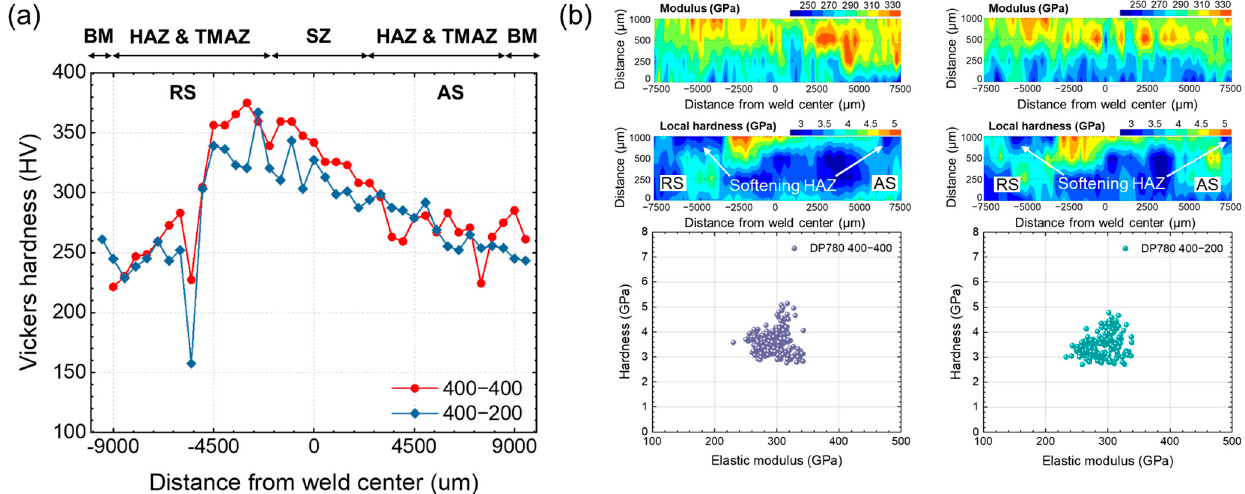
Figure 3. ( a ) The microhardness profile and ( b ) cross-sectional local hardness maps (4 × 60 = 240 indent matrix with a spacing of 250 μ m and a maximum depth of 1.5 μ m) for the joint in the FSW400-200 and FSW400-400. The black and white arrows correspond to the area of the softening HAZ.